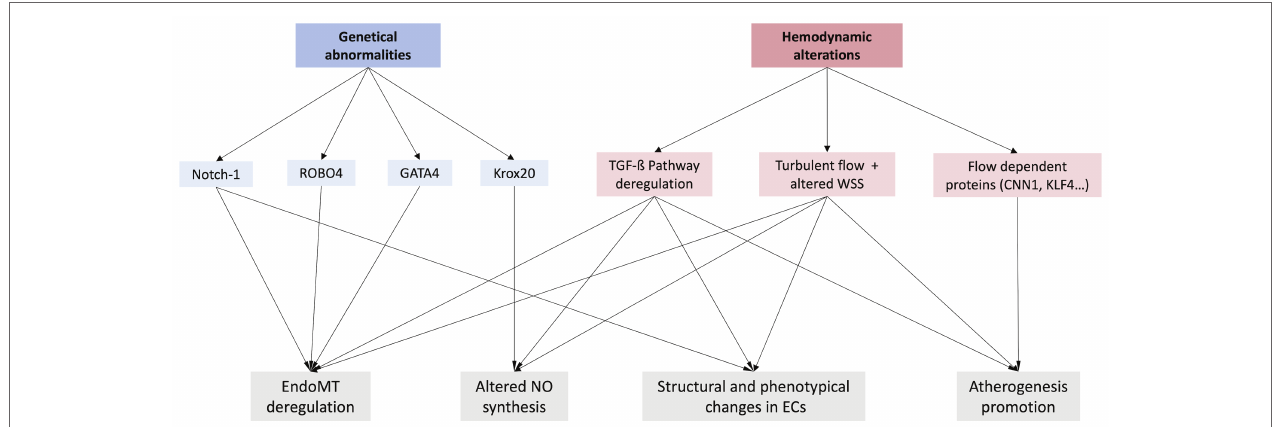
FIGURE 2 | Representation of the two main hypothesis about a possible ED in BAV disease (genetical abnormalities and/or hemodynamic alterations), as well as some of the most relevant phenomenon these variations may provoke. Notch-1, Neurogenic locus Notch homolog protein 1; ROBO4, Roundabout guidance receptor 4; GATA4, GATA binding protein 4; Krox20, Early growth response 2; EndoMT, Endothelial-to-mesenchymal transition; NO, Nitric oxide; TFG-ß, Transforming growth factor ß; WSS, Wall shear stress; CNN1, Calponin-1; KFL4, Krüppel-like Factor